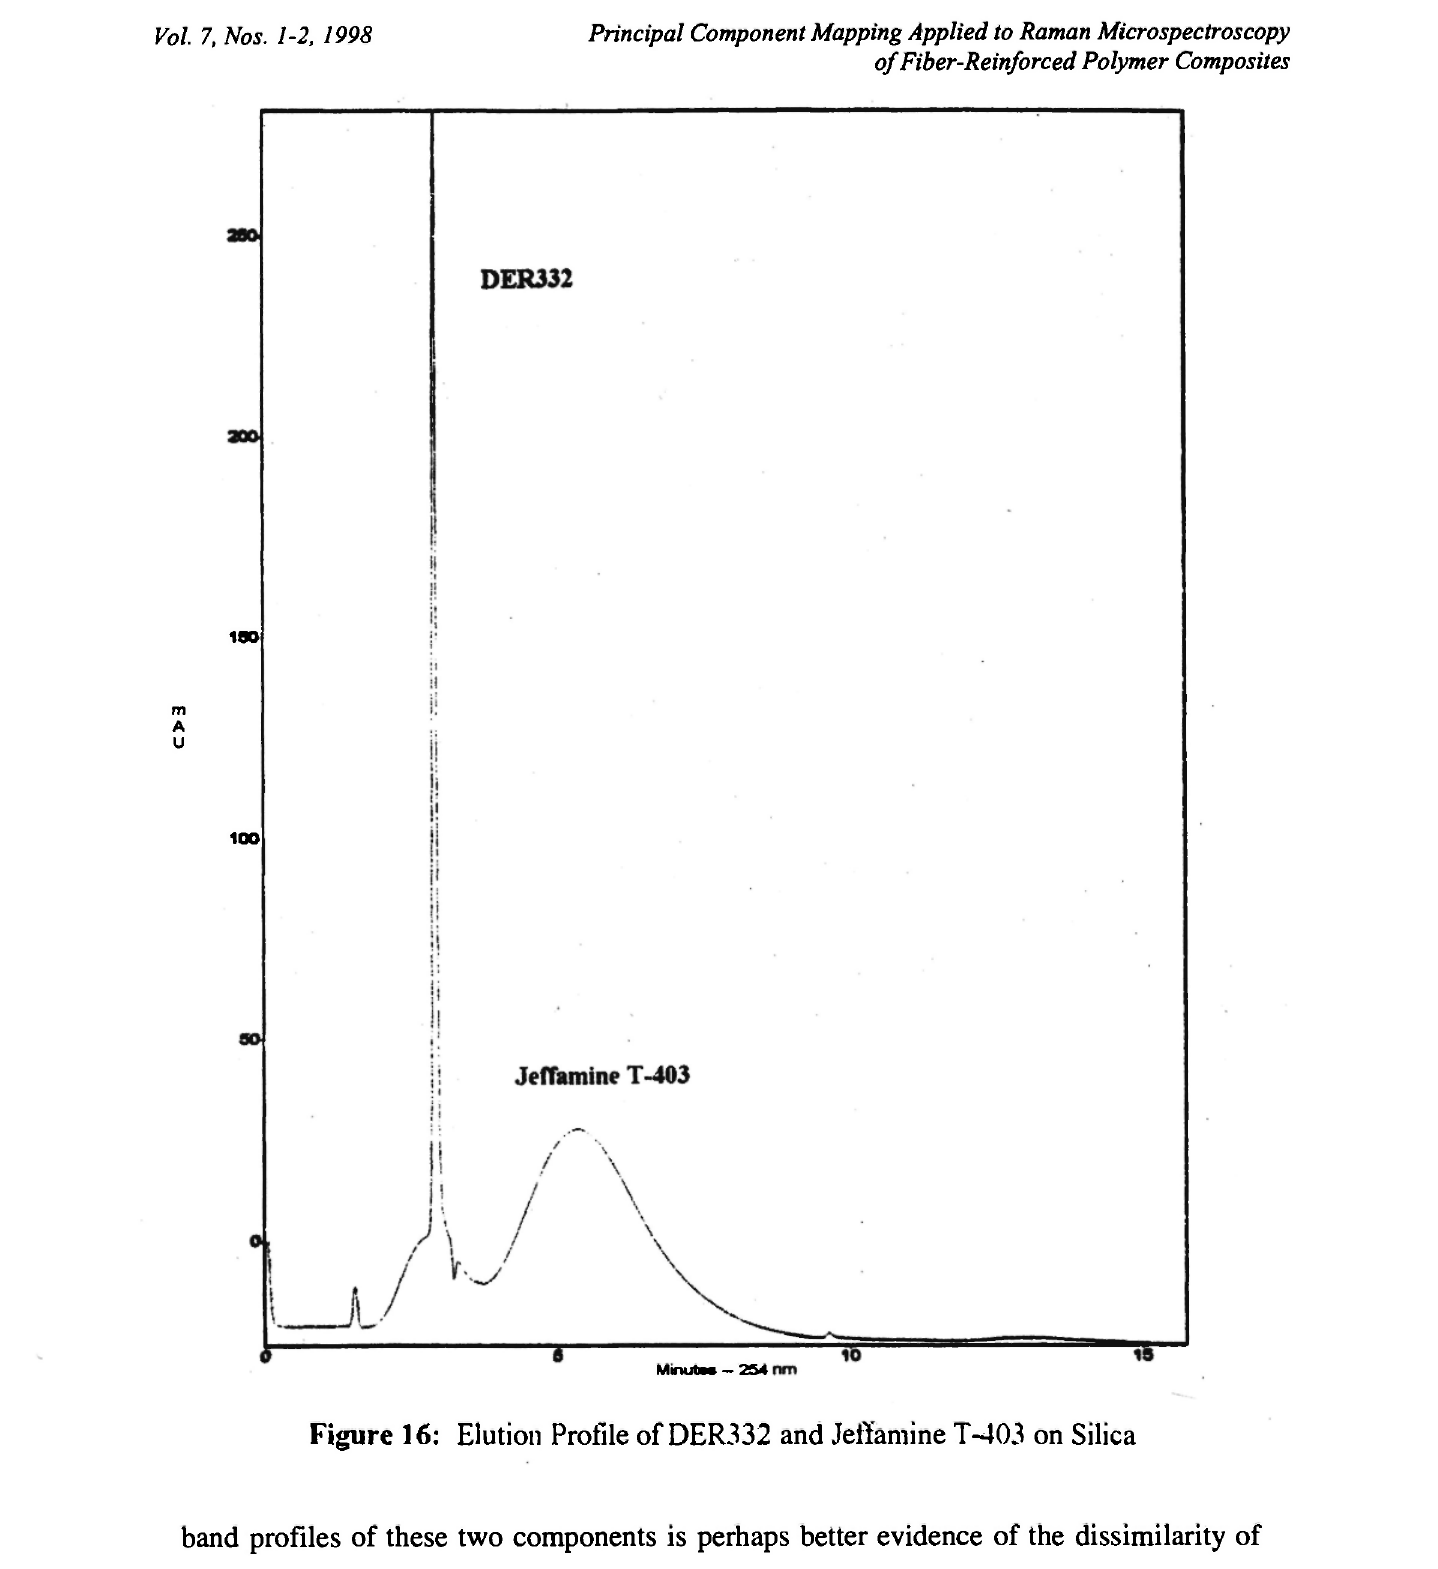
Figure 16: Elution Profile of DER332 and Jeftaniine T-403 on